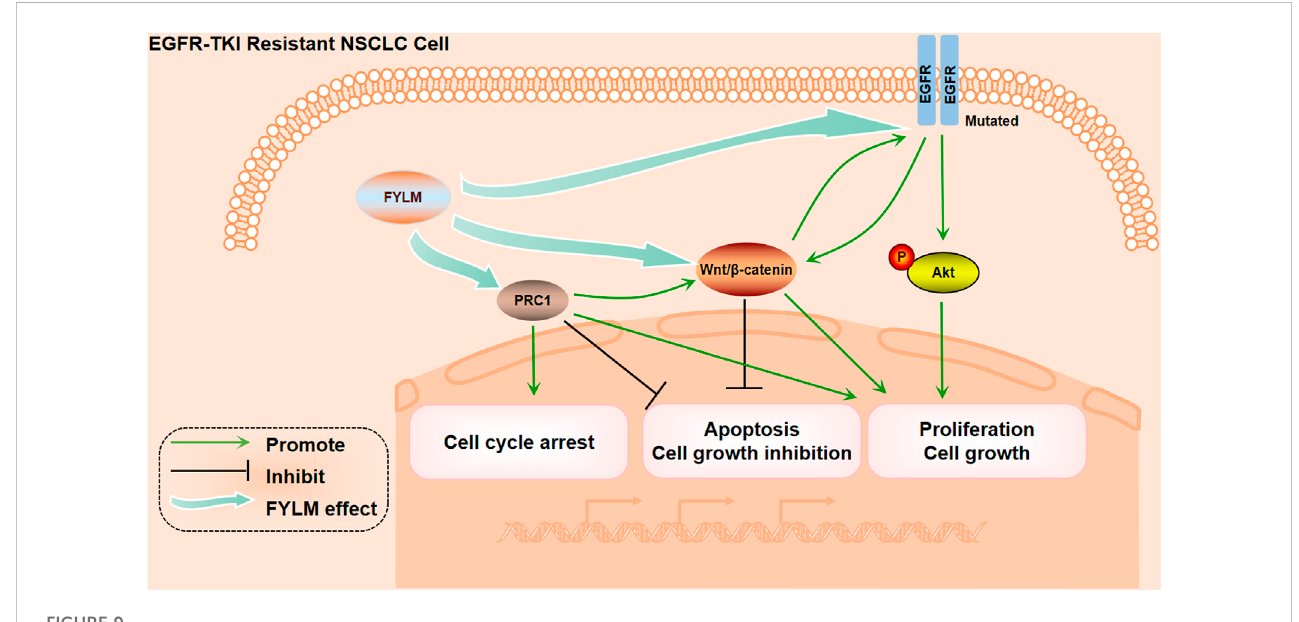
FIGURE 9 The Mechanism diagram of FYLM alleviating drug